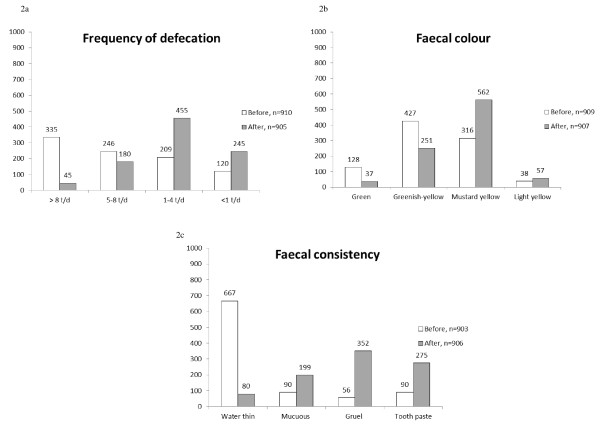
Frequency histograms of rated gastrointestinal (feacal) symptoms.